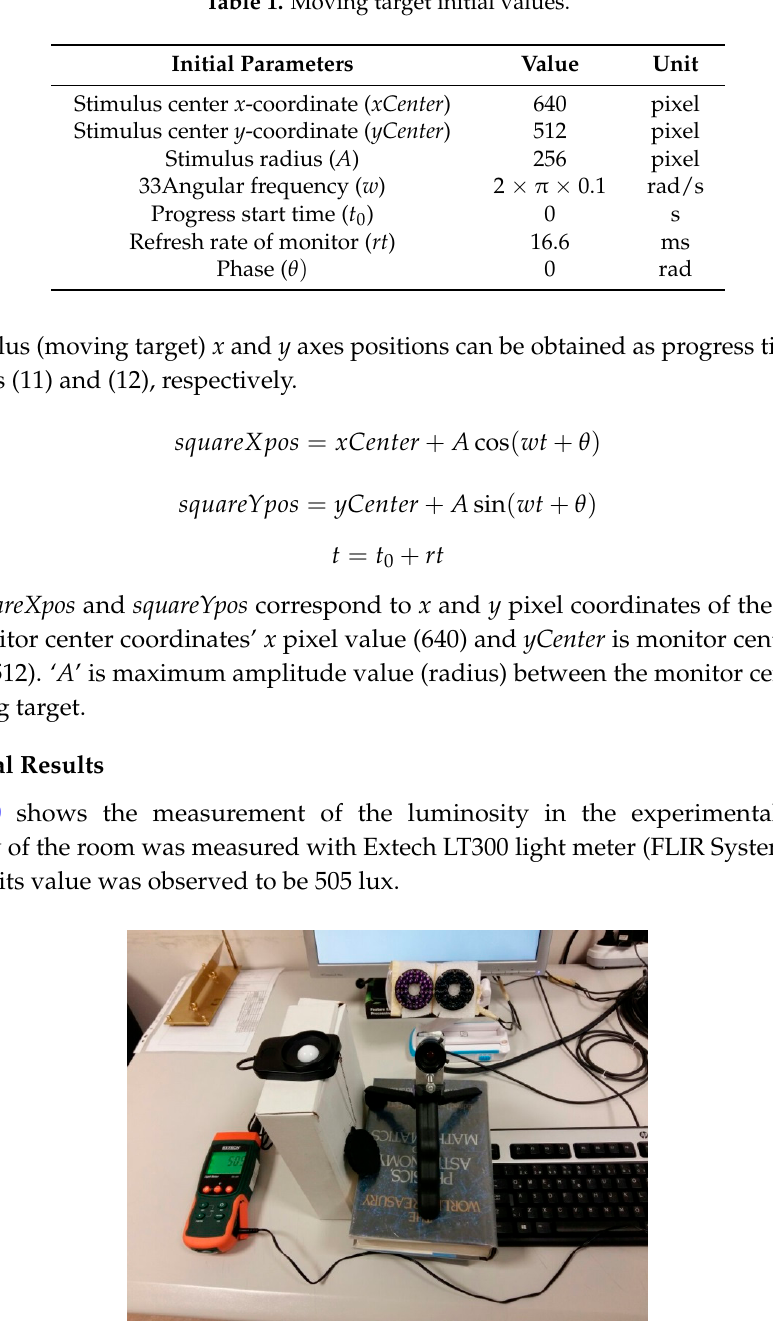
Table 1. Moving target initial values.